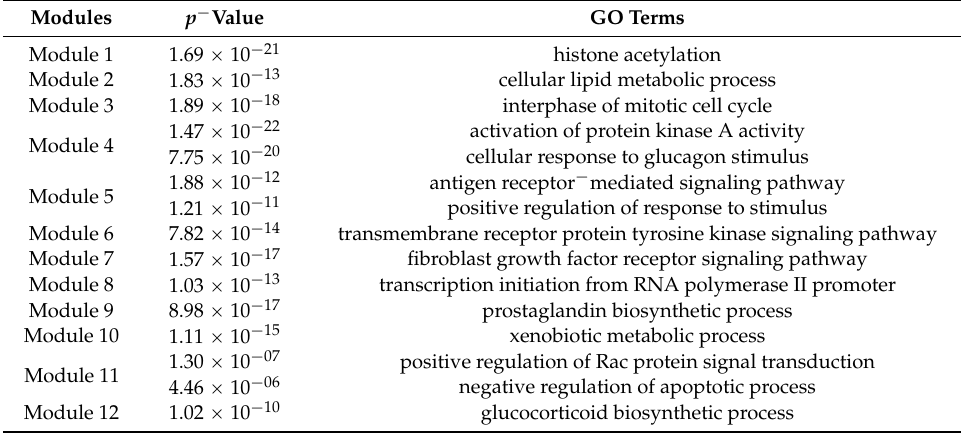
Figure 4. A set of 12 modules were identified from the PIN of GTs. Table 3. GO biological process terms of the modules display